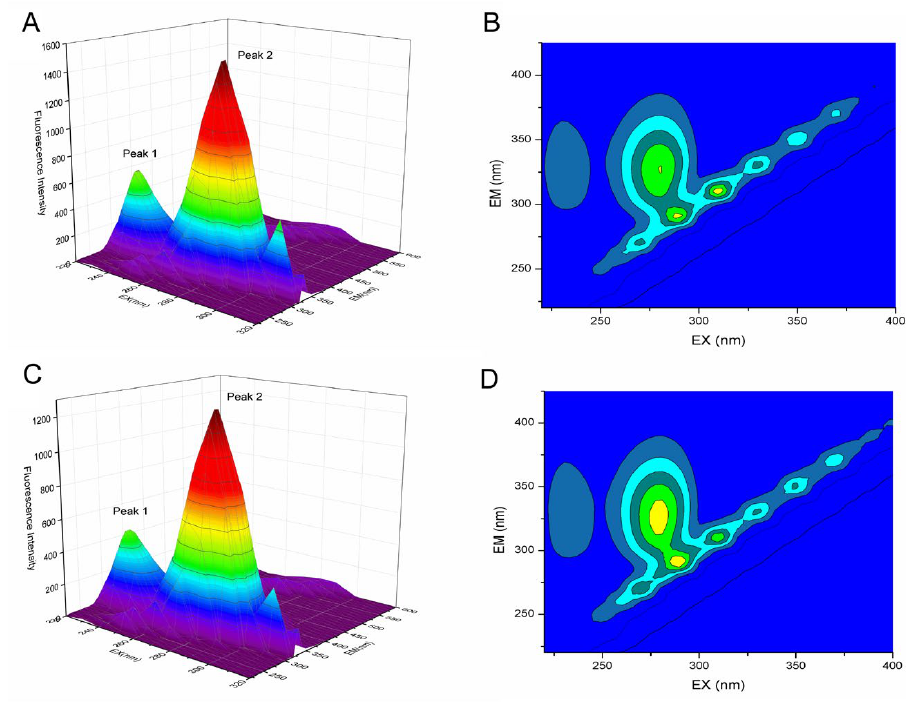
Figure 5. Three-dimensional fluorescence spectra and contour map of HSA ( A , B ) and astilbin − HSA Table 4. Three-dimensional fluorescence spectral characteristic parameters of HSA and astilbin − HSA system.